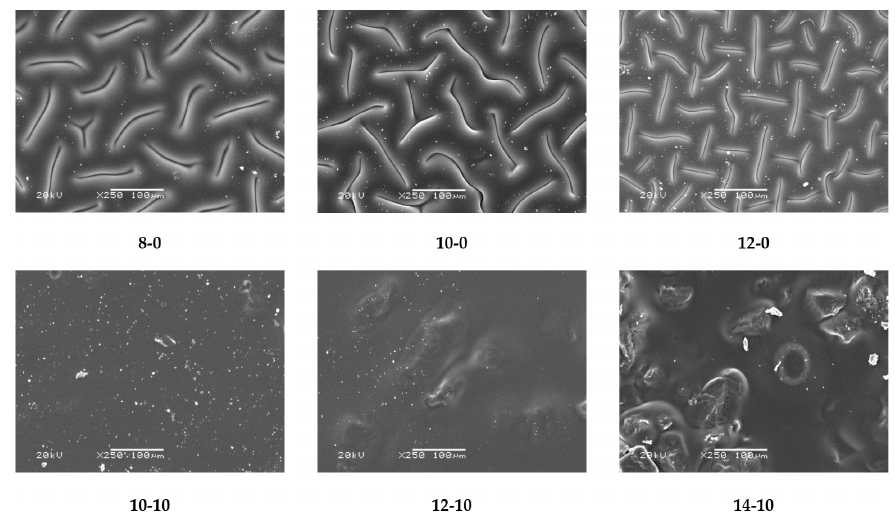
Figure 5. SEM images of obtained hydrogel materials.